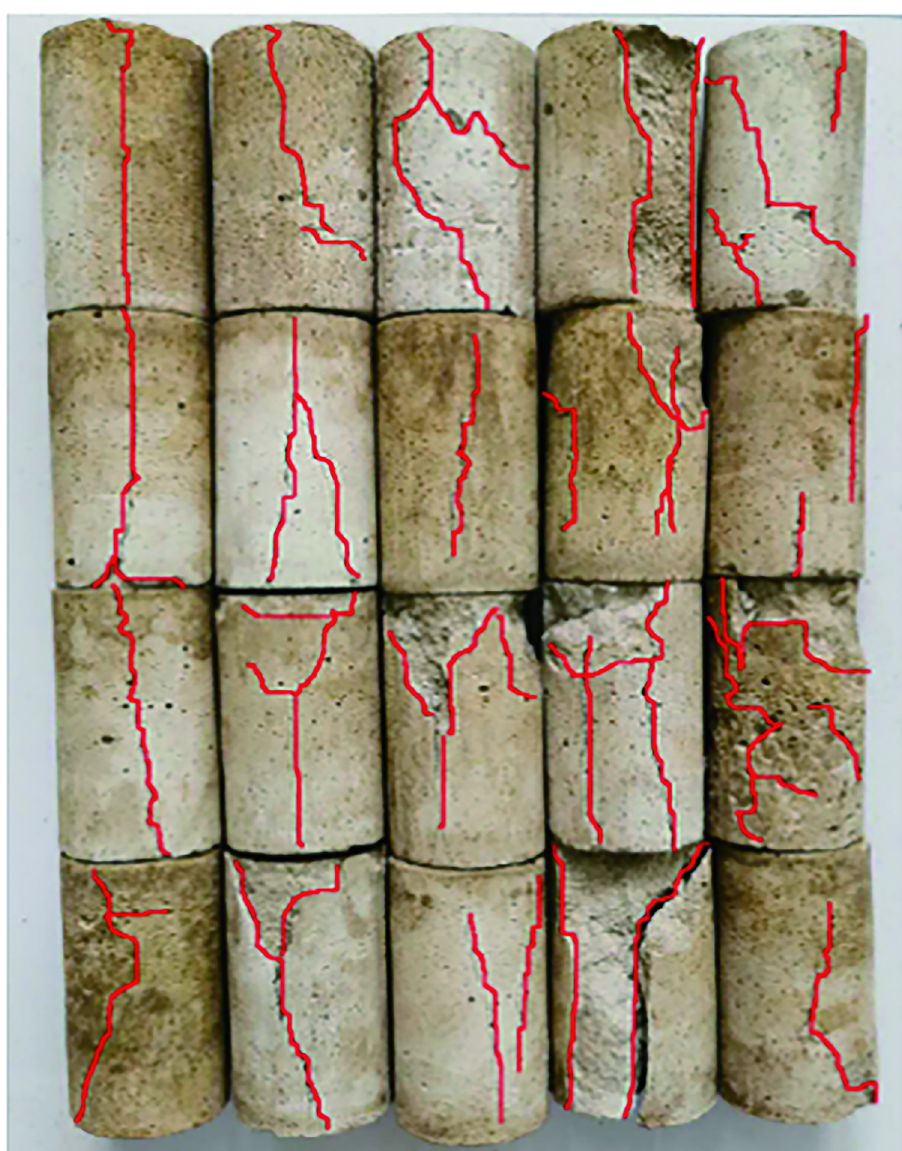
Fig 19. Photograph showing similar material failure patterns. were different; the slope of the curve became zero when the stress peak was reached. Owing to the brittleness of rockburst-like materials and white sandstone, the plastic deformation of the specimen was extremely small. When plastic deformation occurred, the particles inside the rock slipped and deformed. In addition, a pressure-solution recrystallization of the rock sub- ject to the action of strong stress was a mechanism for the plastic deformation of the rock. Fourth stage: the destruction stage. Herein, the curve dropped rapidly and the slope of the curve assumed a negative value. When the external force applied to the rock exceeded the strength limit that the rock can bear, the internal structure of the rock was damaged; this resulted in a fractured surface.